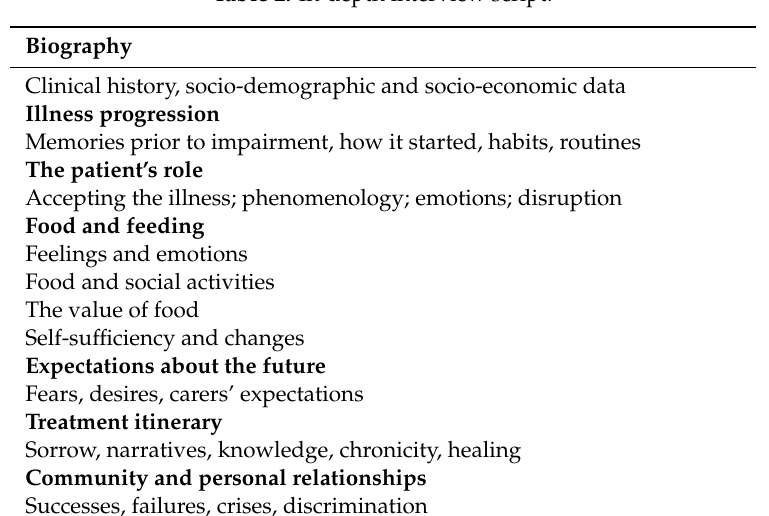
Table 2. In-depth interview